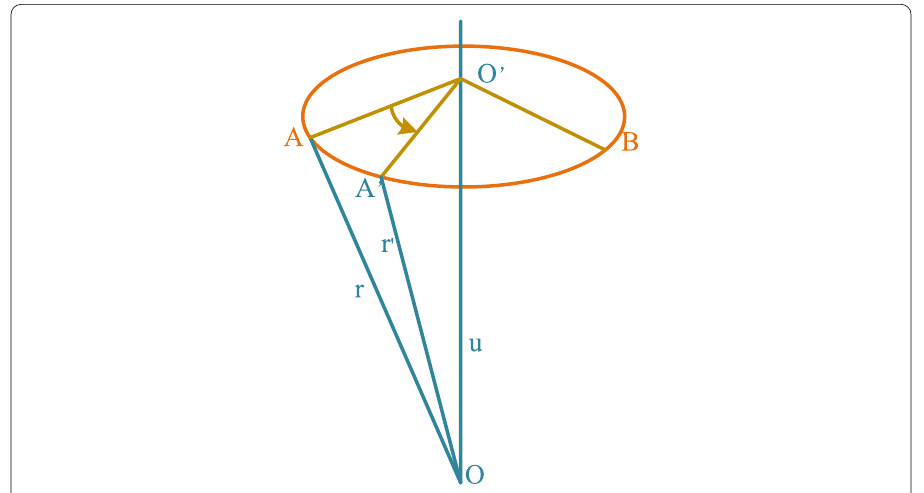
Fig. 5 Schematic diagram of equivalent conversion effect of coordinate